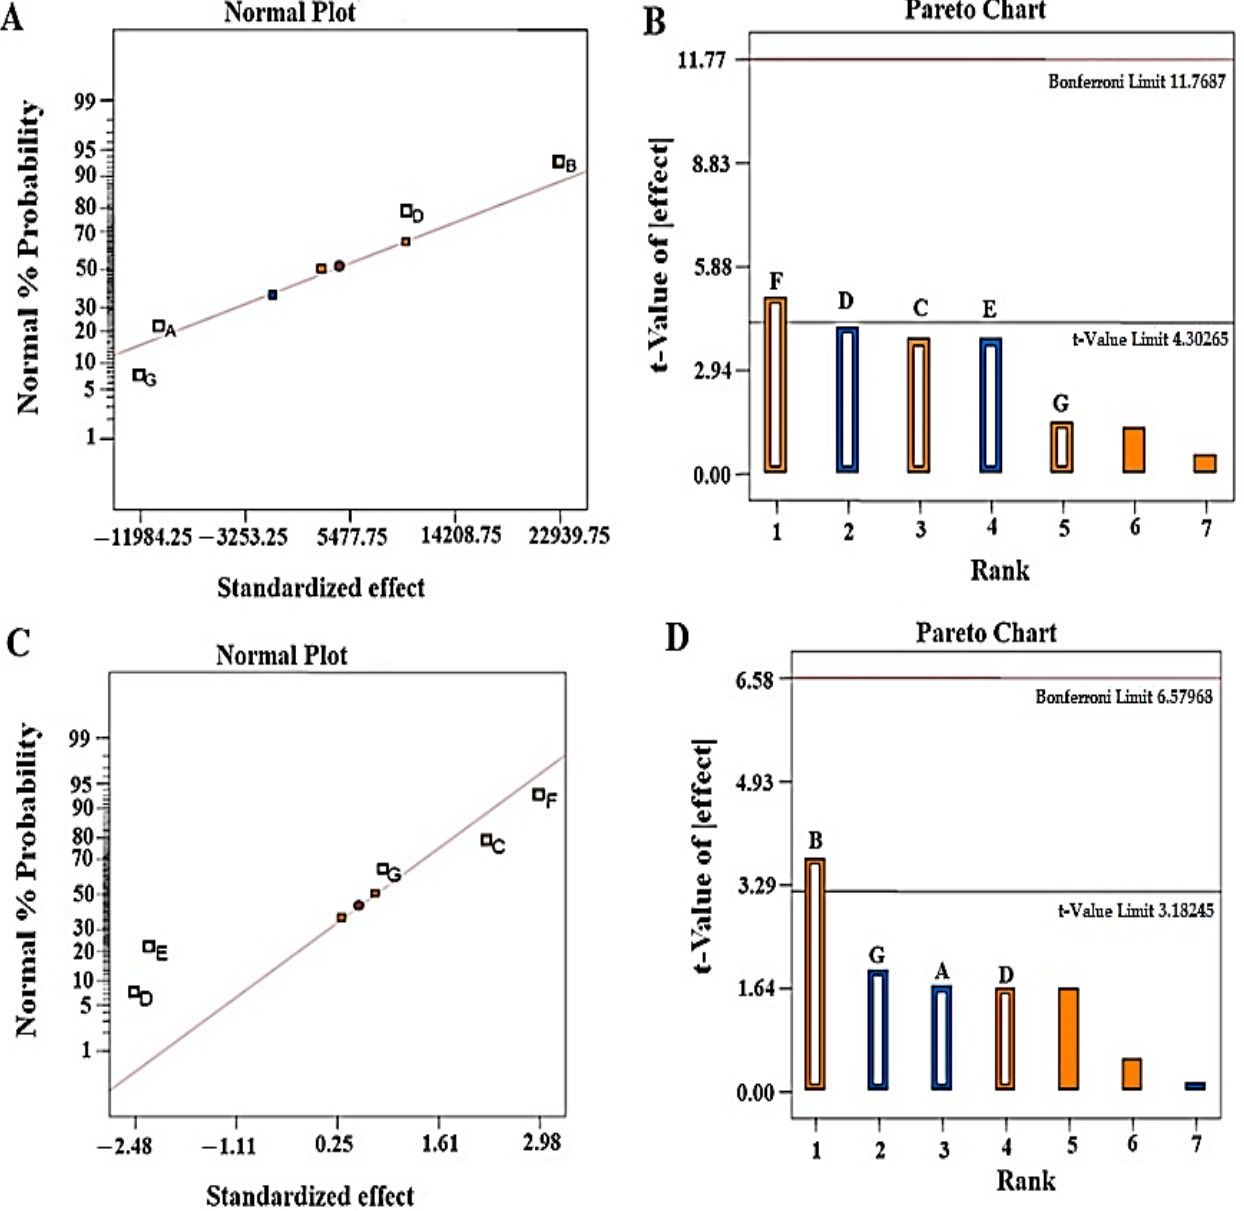
Figure 2. Half-normal and Pareto charts depicting the significant effect on bioanalytical attributes: ( A , B ) retention time (RT) and ( C , D ) peak area. In Figure 2B,D, the impact of various factors (A–G) has been ordered in the term of rank. These factors have been explained in table 1 and footnote.